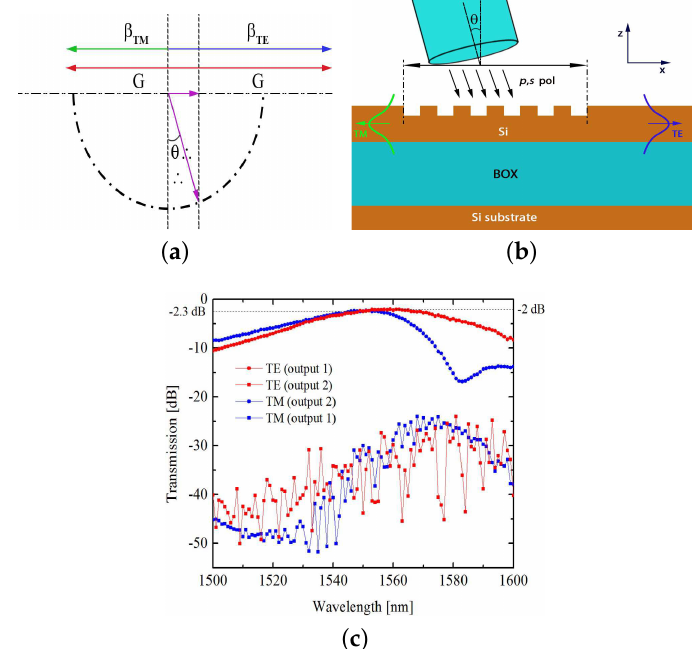
Figure 14. ( a ) Phase matching in k - space for 1D polarization splitting grating coupler. ( b ) Design schematic of mode of operation. Polarization splitting results in contra-directional coupling of the fundamental modes. ( c ) Measured coupling efficiency for the two polarization states (reprinted with permission from